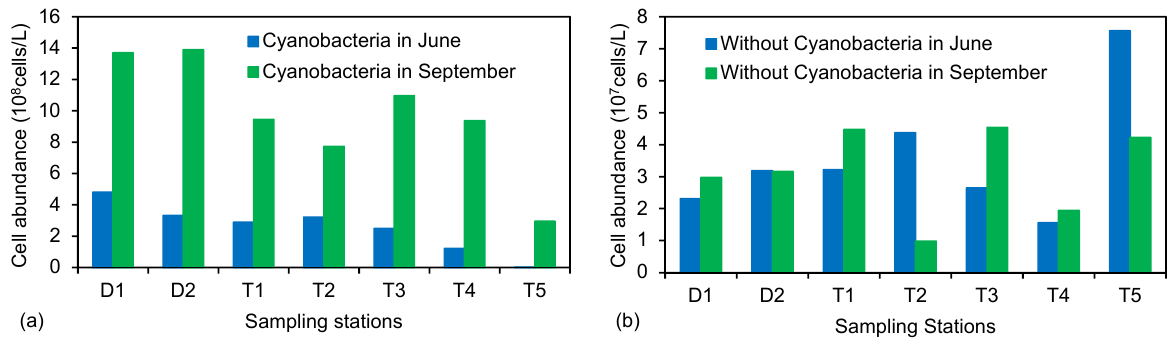
Figure 5. Comparisons between ( a ) the abundance of Cyanobacteria in June and in September and ( b ) the abundance without Cyanobacteria in June and in September.